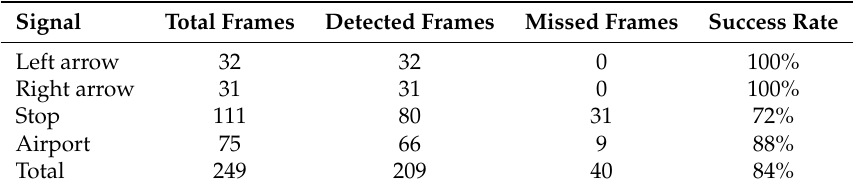
Figure 17. Trajectory followed by the robot for the Cascade and You Only Look Once (YOLO) algorithms. Table 1. Results of object detection with cascade classifier.